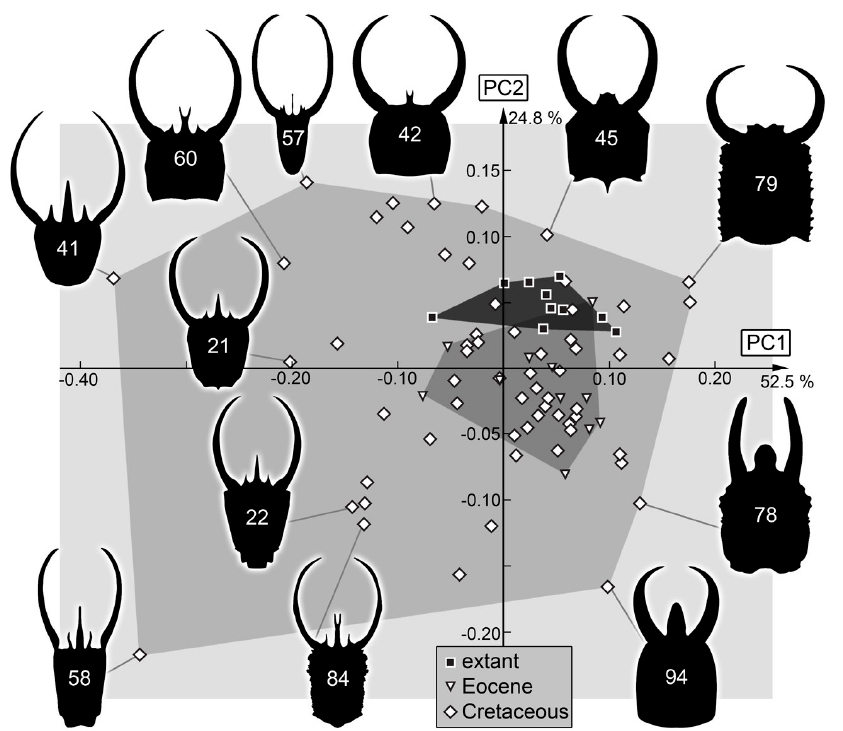
Figure 31. Scatterplot of PC2 vs. PC1 values of head + stylet shapes (see Supplementary Materials File S2 for details).